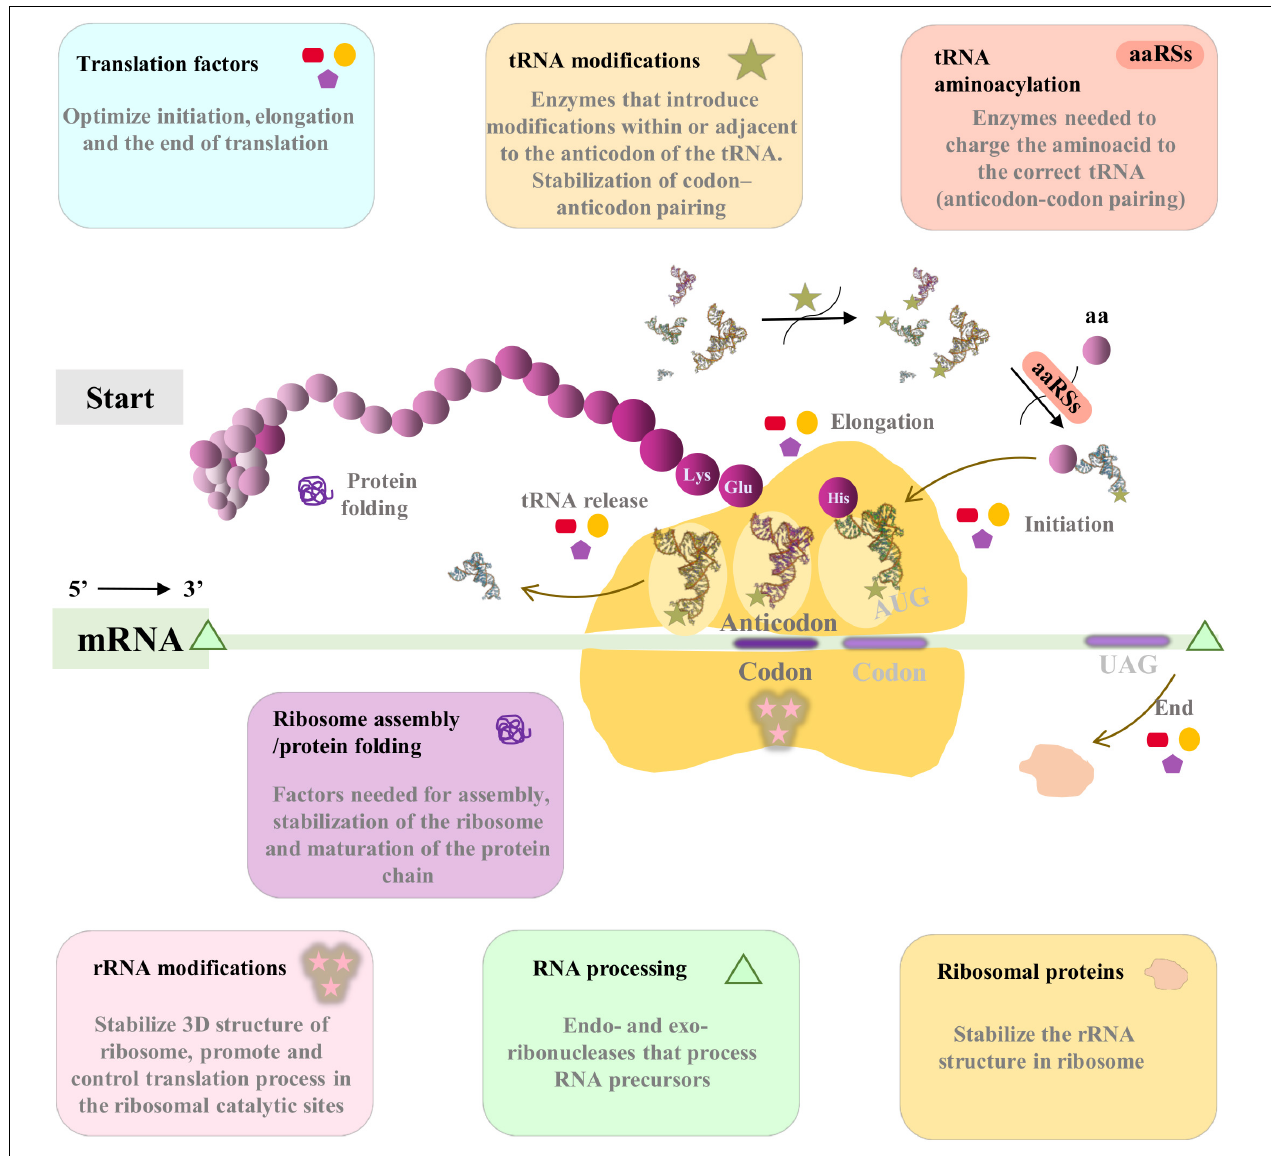
FIGURE 1 | Simplified schematic view of translation in bacteria. In this work all the proteins included in translation machinery are classified in seven functional categories: ribosomal proteins (orange), tRNA aminoacylation (coral), rRNA modifications (pink), tRNA modifications (wheat), ribosome assembly/protein folding (orchid), Translation factors (blue), and RNA processing (green). The most important functions are summarized in the respective panels of each category. The tRNA structure corresponds to tRNA(Ile) from PDB database (1FFY; Silvian et al., 1999), and has been modified with PyMOL software (Schrödinger and DeLano, 2020) for this